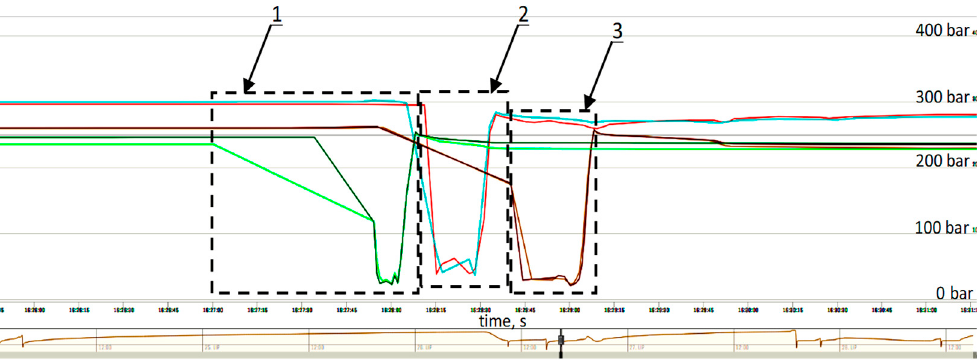
Figure 10. The pressure value progress after installing the automatic expansion system for the selected powered support: 1, working time of powered support no. 43 is 67 s; 2, working time of powered support no. 44 is 27 s; 3, working time of powered support no. 45 is 28 s.